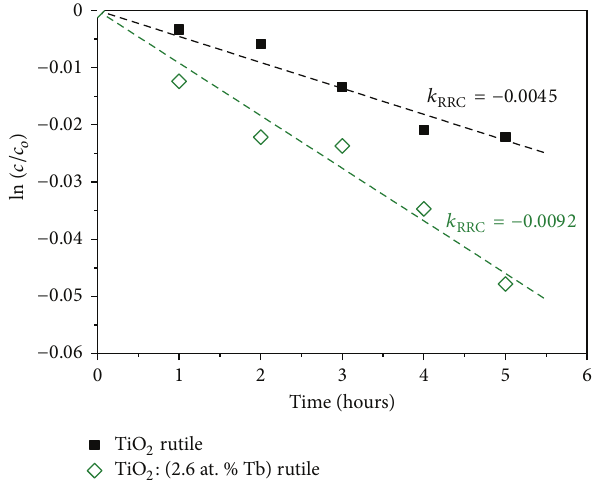
Figure 5: Photocatalytic activity of TiO 2 and TiO 2 :Tb thin films with rutile structure exposed to UV light time function based on dependence of ln (𝑐/𝑐 𝑜 )